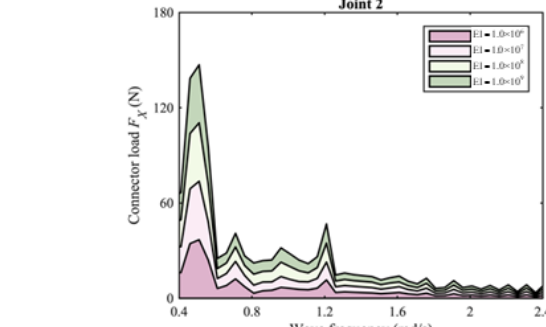
Figure 9. Constraint forces on each module under the action of connectors.